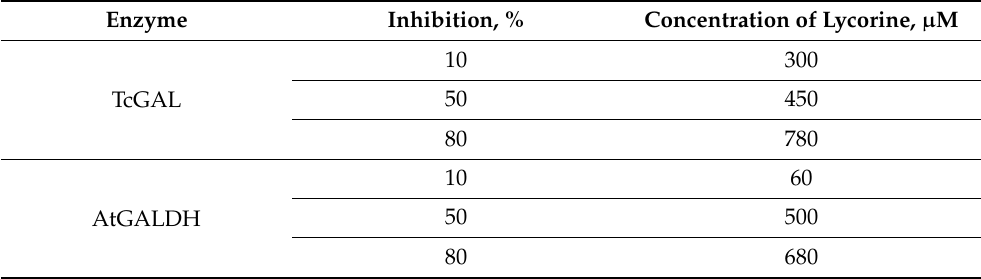
Table 5. The comparison of the inhibition effect of lycorine in micellar media (0,1 M AOT in